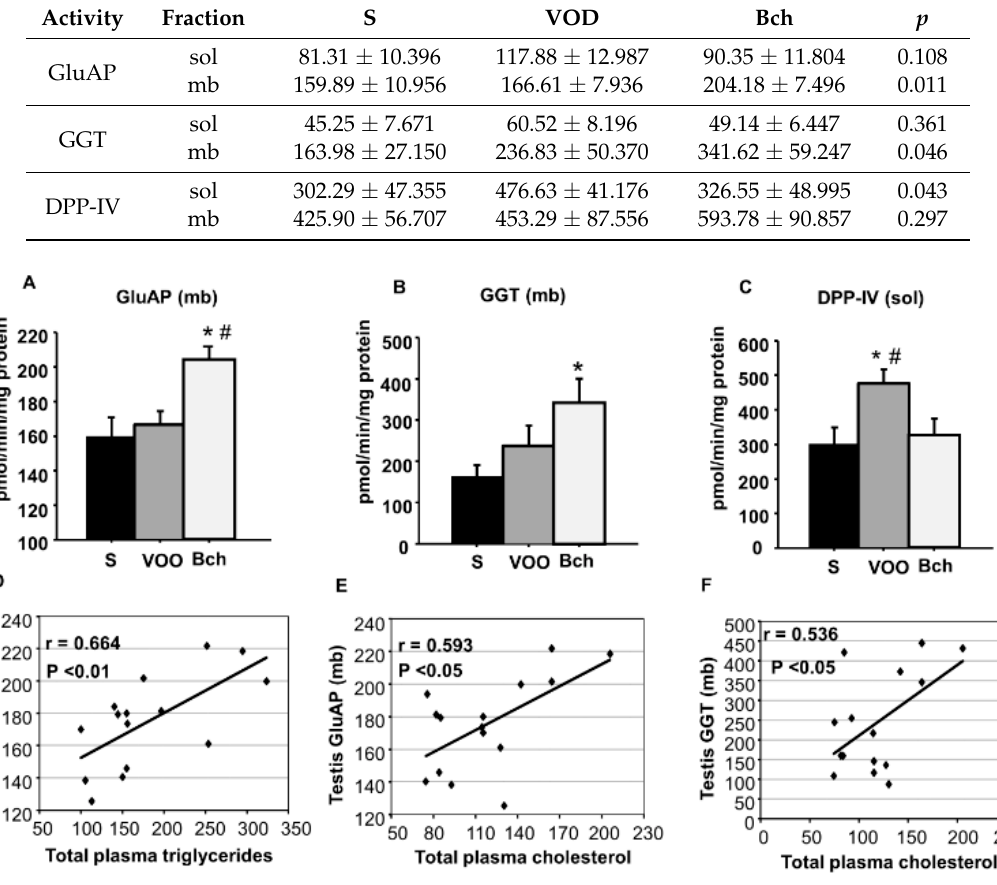
Figure 3. Values represent mean and SEM levels of membrane bound (mb) GluAP activity ( A ), mb GGT activity ( B ) and soluble (sol) DPP-IV activity ( C ) in animals fed standard (S), virgin olive oil (VOO) and butter plus cholesterol (Bch) diets. Values are expressed as pmol of the corresponding aminoacyl- β -naphtylamide hydrolyzed per minute and per mg of protein. * ( p < 0.05), differences vs. standard diet. # ( p < 0.05) differences vs. butter plus cholesterol diet. The significant correlations that were observed when testicular sol or mb enzymatic activities and plasmatic lipids were compared are also represented ( D – F ), indicating r and p values.